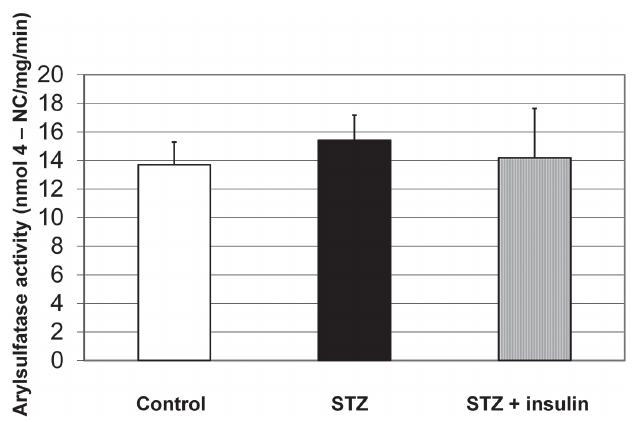
FIGURE 7 - Cumulative biliary excretion of PNP after the 90- min luminal perfusion of 500 µM PNP in control and diabetic rats without or with insulin administration. Data represent the mean of ± S.E. of seven rats. Significant difference from the control value: ** p<0.01. No significant differences were found between the values of STZ-diabetic rats without or with insulin